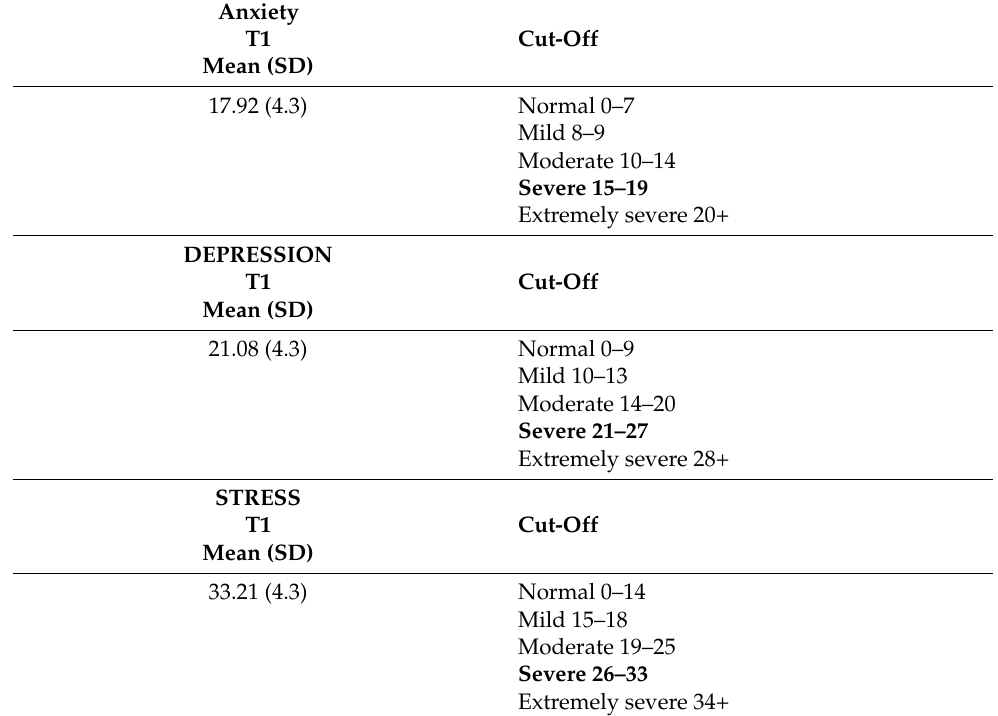
Figure 1. Mean percentage of responses for anxiety, depression, and stress scales (DASS-21) at two time-points: one month before (T0) and one month after the COVID-19 confinement (T1). * p < 0.001 T0 vs. T1. Table 1. The mean scores of the anxiety, depression, and stress scale (DASS-21) at T1 compared to normative data [60].